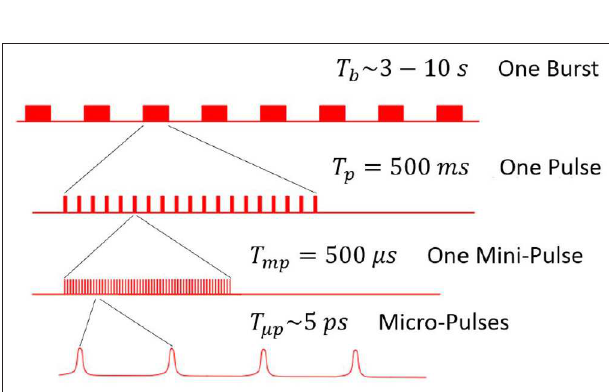
FIGURE 2 | Schematic of the four coordinate systems used within this paper, Earth-centered Cartesian and spherical coordinates, {ˆ X , ˆ Y , ˆ Z centered Cartesian and spherical coordinates